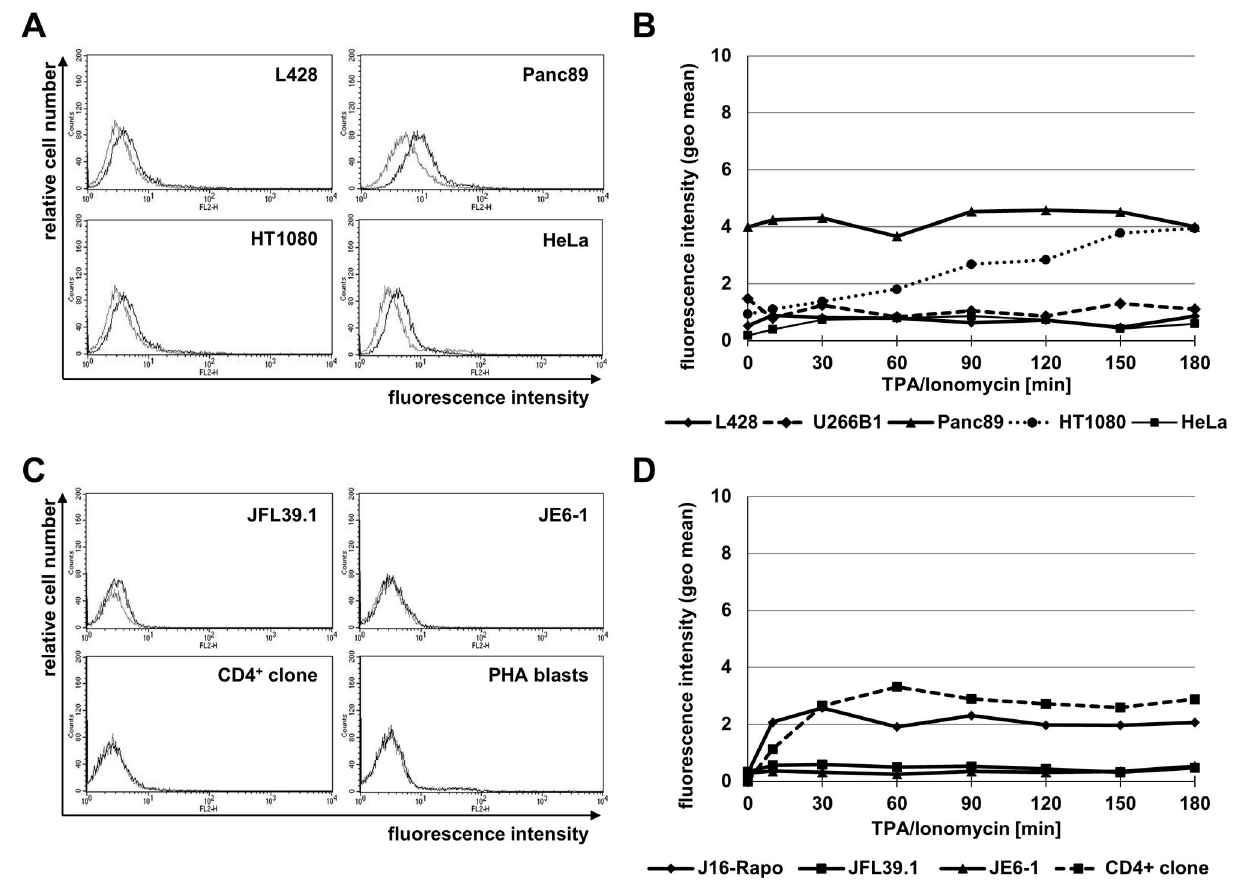
Figure 6. Surface expression and modulation of ADAM17. A. The constitutive surface expression of ADAM17 was monitored on Hodgkin’s Lymphoma (L428), pancreatic ductal adenocarcinoma (Panc89), fibrosarcoma (HT1080) and cervical carcinoma (HeLa) cell lines. Unstimulated cells were stained with an isotype control or anti-ADAM17 mAb (clone A300E) and PE-conjugated anti-mouse second step antibodies. Histograms display fluorescence intensities against relative cell numbers. B. Activation- dependent alterations in ADAM17 surface abundance were monitored on the listed tumor cell lines (including U266B1) at the indicated time points after stimulation with TPA and Ionomycin. For each time point, cells were stained for ADAM17 as described. Individual data points represent geometric mean values calculated from individual histograms using CellQuestPro. C. The indicated leukemic and untransformed T cell populations were analyzed for constitutive expression of ADAM17. D. Activation-induced modulation of ADAM17 was analyzed for a period of three hours upon stimulation with TPA and Ionomycin on transformed Jurkat variants and an untransformed T